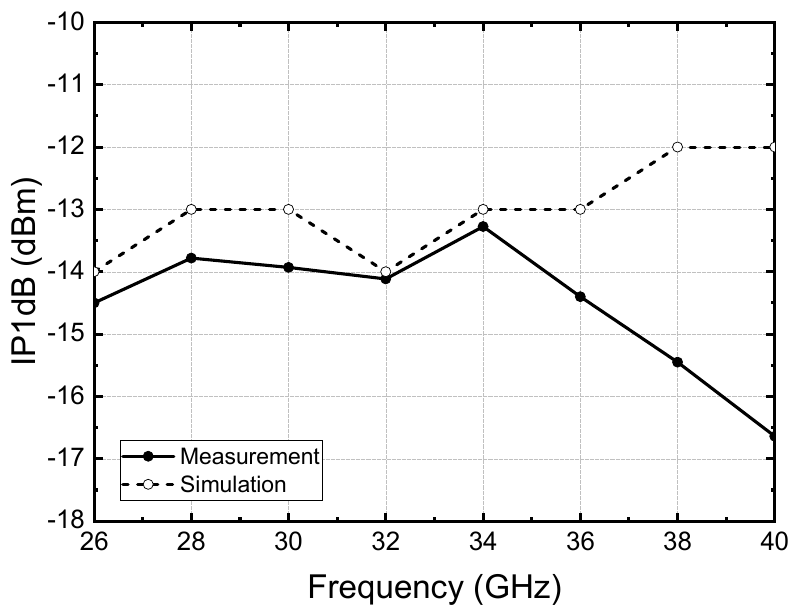
Figure 13. Measured IP1dB versus frequency.